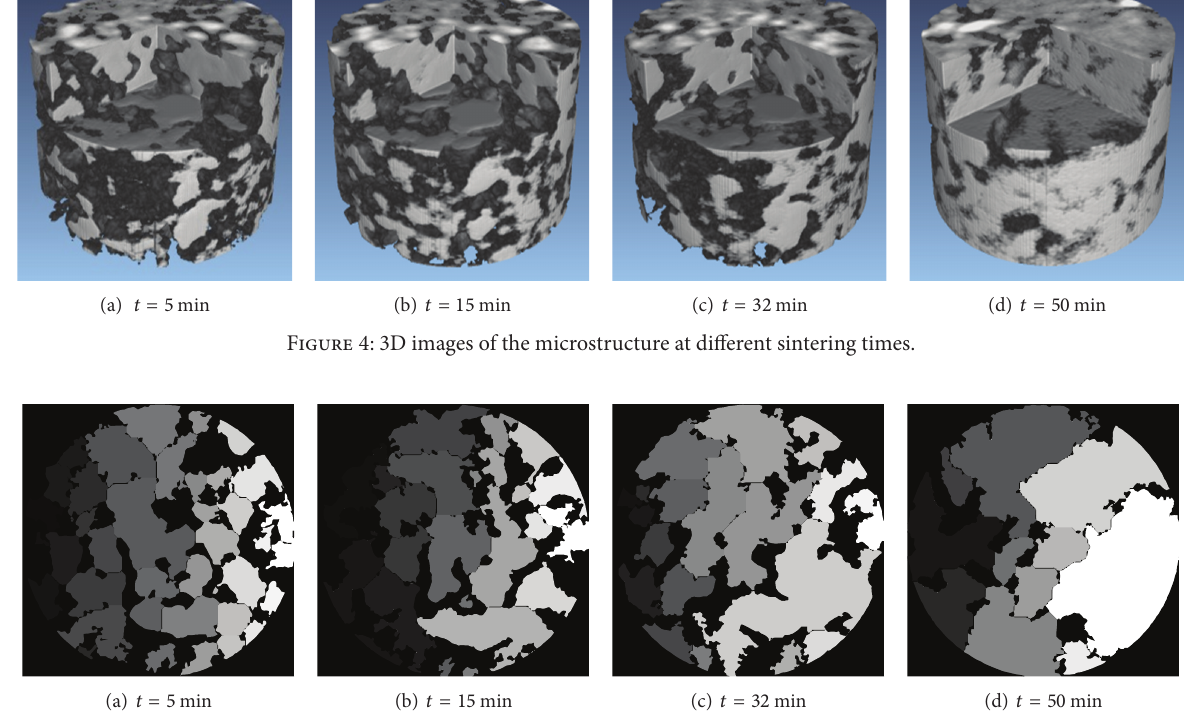
Figure 5: Microstructure of the same cross section using the watershed algorithm.